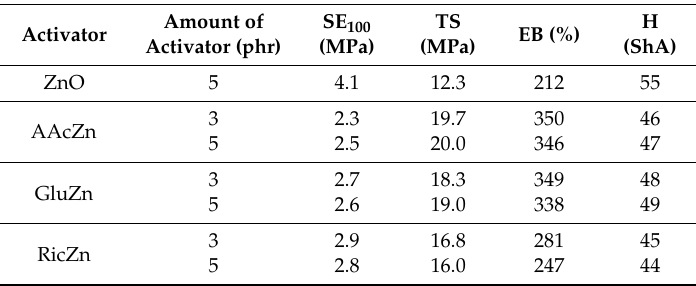
Table 4. Mechanical properties and hardness of SBR vulcanizates (SE 100 —modulus at a relative elongation of 100%, TS—tensile strength, EB—elongation at break, H—hardness, standard